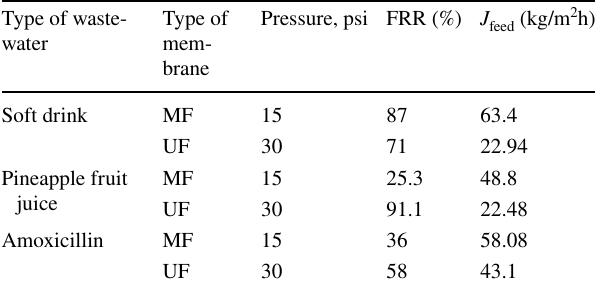
Table 7 FRR and J Feed measured for MF and UF membranes for type of wastewater Type of waste-